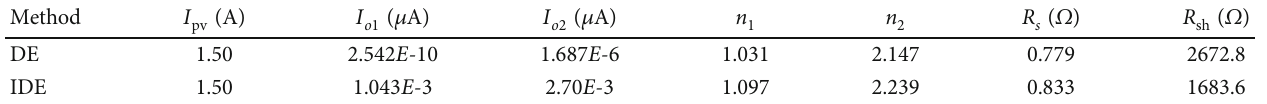
Table 4: Extraction parameters of S25 module with di ff erent methods.